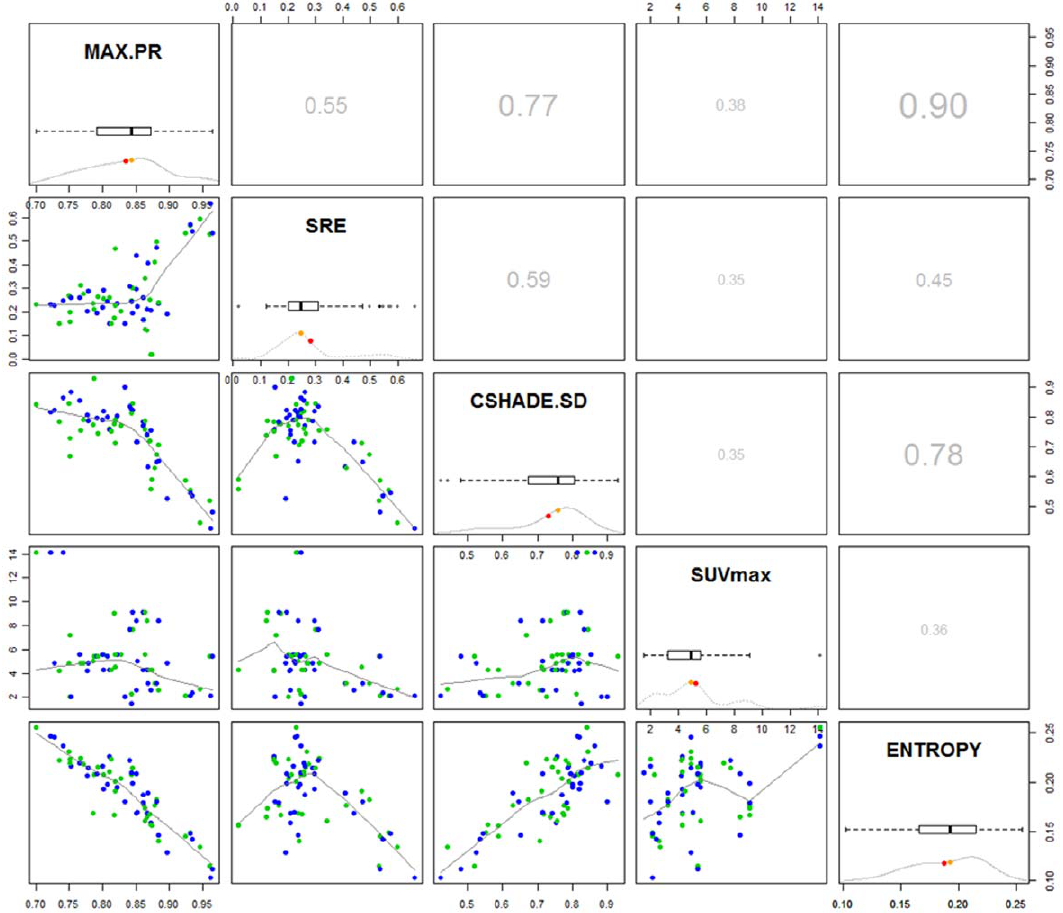
Figure 7. The selected five best informative features, and their histograms, box-plots with mean and median (diagonal), one-to-one regression curves in matrix row-column format (in lower panel), and spearman correlation values (in upper panel) are given.